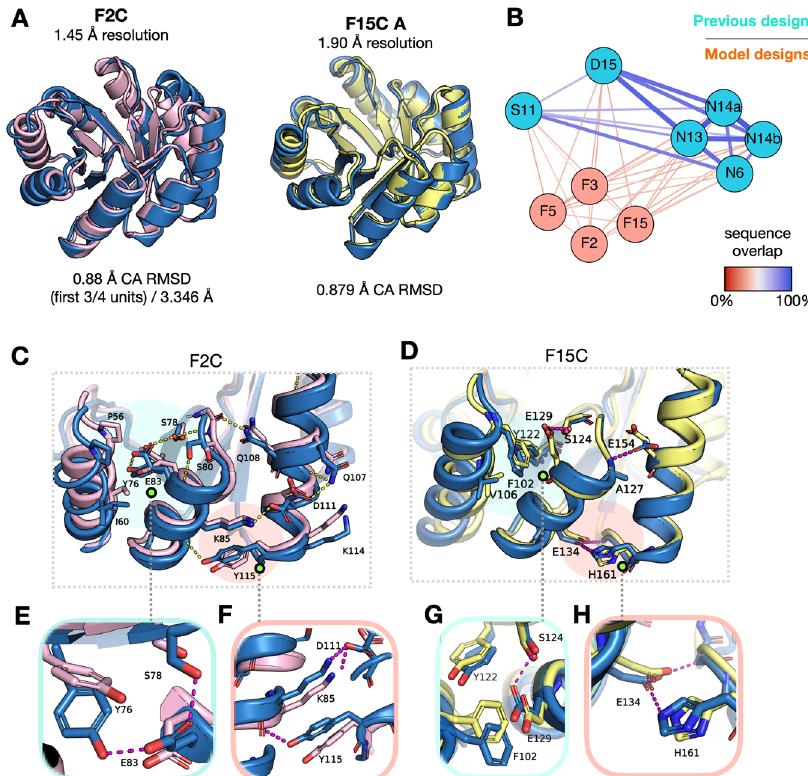
Fig. 4 Model discovery of novel sequence features. A Overlay of crystal structures (blue) with template TIM-barrel backbone for F2C (pink) and F15C (yellow). Alpha-carbon RMSD (Å) and sequence identity to sTIM-11 sequence 44 are given below structures. B Percent sequence identity (indicated by graph edge color and thickness) between TIM-barrel subunits for model TIM-barrel designs (orange) and previously characterized sequences for the same scaffold (blue), including sTIM-11 ( 5bvl , S11) 44 , DeNovoTIM15 ( 6wvs , D15) 77 , and DeNovoTIMs (N6, N13, N14a, N14b) 48 . N14a and N14b are two-quarters of the two-fold symmetric DeNovoTIM14. C , D Investigation of sequence features for the symmetric subunit near the top of the barrel (cyan shadow) and the helix interface between symmetric subunits (orange shadow) for C F2C and D F15C. Crystal structures are shown in blue overlaid with the design template (pink — F2C, yellow — F15C). E – H Closer inspection of novel sequence features designed by the